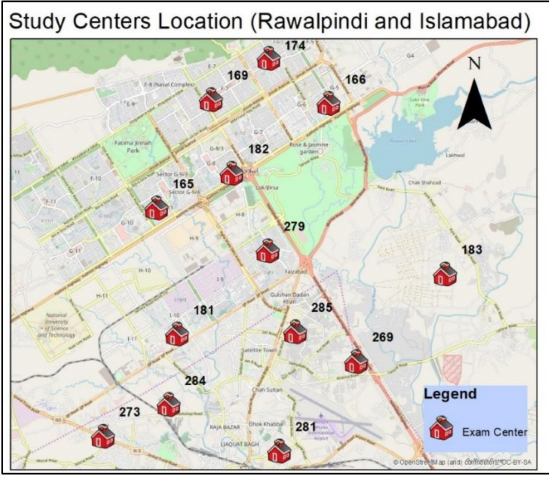
Figure 2. Study centers (Rawalpindi/Islamabad).